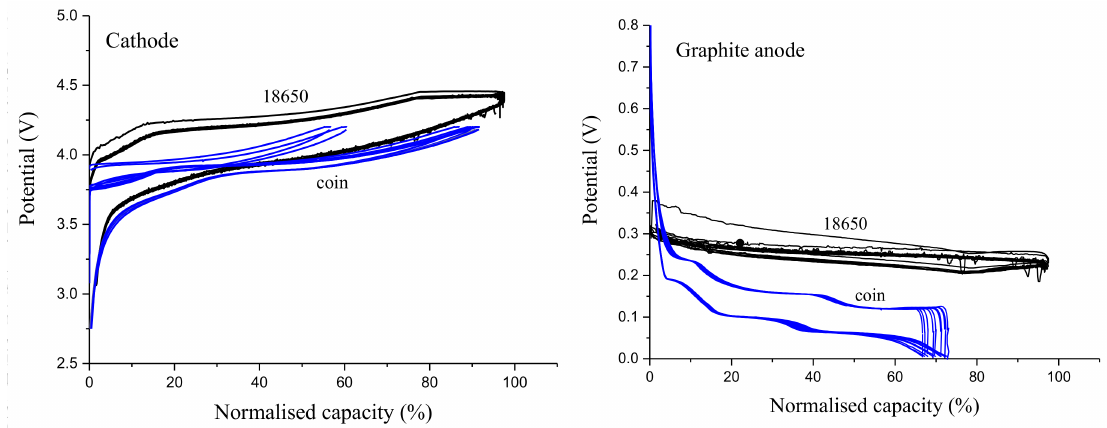
Figure 7. Coin cell potentials (blue curve) for the cathode (on the left) and the graphite anode (on the right) and the three-electrode 18650 cell electrode potentials (black curve) vs. capacity. The first five cycles of the cathode coin cell are those at higher potentials in the middle of the positive electrode coin cell